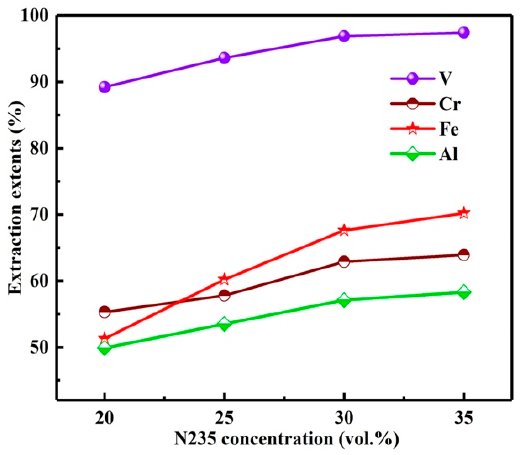
Figure 10. Influence of N235 extractant concentration on extraction extents.